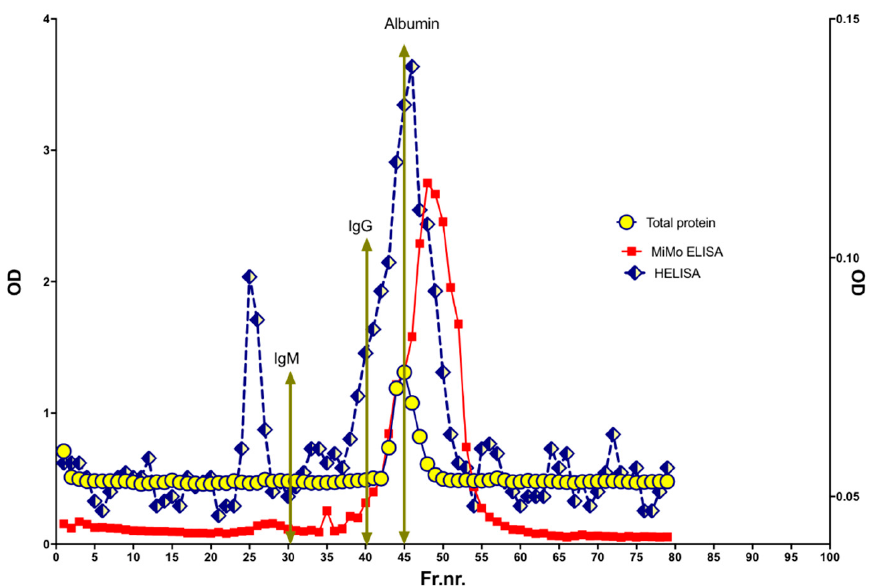
Figure 10. The molecular sizes of CP and NETs in stools were determined by size exclusion chro- matography on a HiLoad 26/600 Superdex 200 column. The expected elution volumes of IgM, IgG, and albumin are indicated by arrows. Most of the NET signals were found in fractions corre- sponding to MW higher and lower than normal CP, suggesting that very little of the fecal CP has a normal